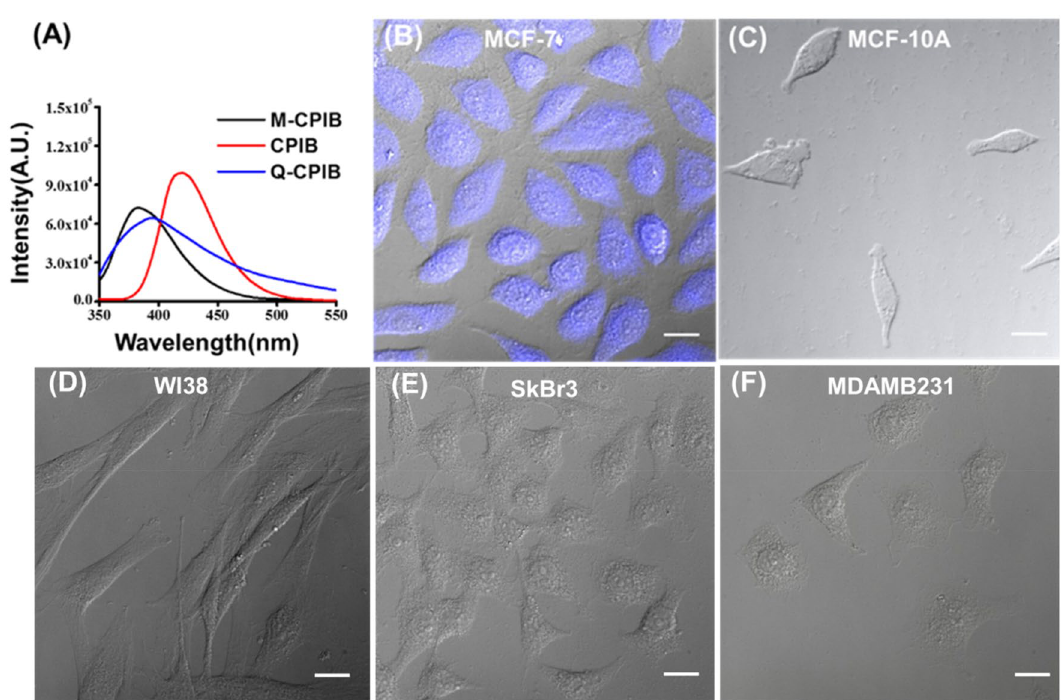
Figure 3. Physical characterization and cellular uptake study of CPIB. ( A ) UV–Vis absorption spectrum of CPIB, M-CPIB and Q-CPIB, CPIB having the maximum intensity among three. ( B ) DIC and fluorescence- merged image of MCF-7 cells (ER positive cells) after treatment of CPIB showed blue fluorescence of MCF-7 cells. ( C – F ) ER negative cell lines showing no blue fluorescence, thus clearly indicating the CPIB target ER of breast cancer cells and emits blue fluorescence. Scale bars correspond to 20